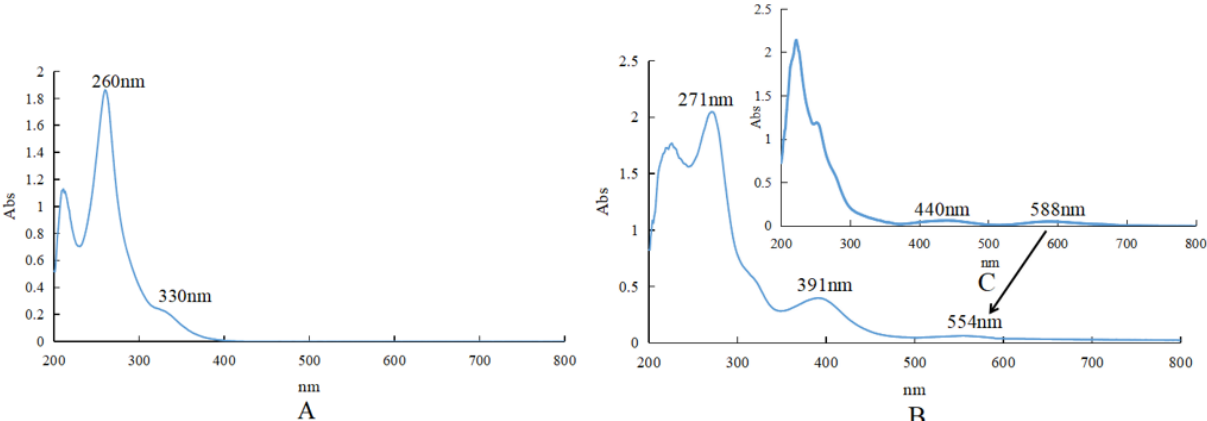
Figure 3. UV spectra. ( A ) UV spectra of BCA, in the solvent of CH3OH, [BCA]=5 × 10 −5 mol·L −1 . ( B ) UV spectra of [CrBCA3], in the solvent of CH3OH, [CrBCA3] = 5 × 10 −5 mol·L −1 . ( C ) UV spectra of Cr(CH3COO)3, in the solvent of CH3OH, [Cr(CH3COO)3 ] = 1 × 10 −4 mol·L −1 .